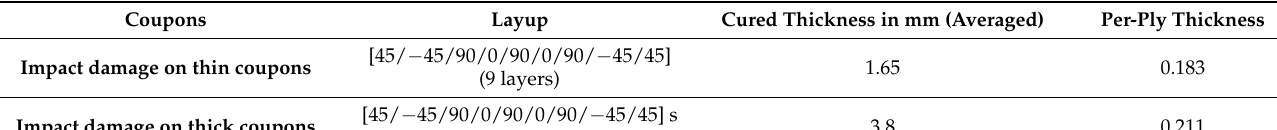
Table 2. Layup and thickness of coupons.